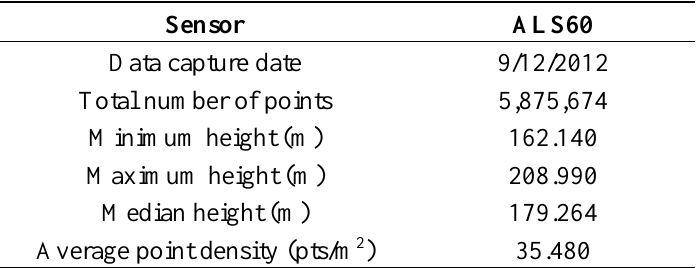
Figure 2. Scanning LiDAR data for the study area. Table 1. Detailed LiDAR parameters for the study